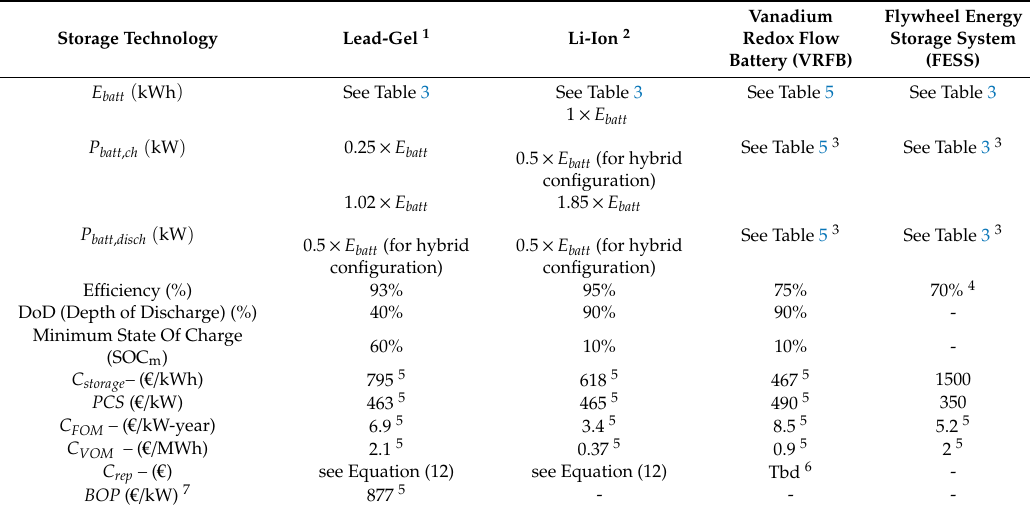
Table 2. Specifications and costs for the storage technologies